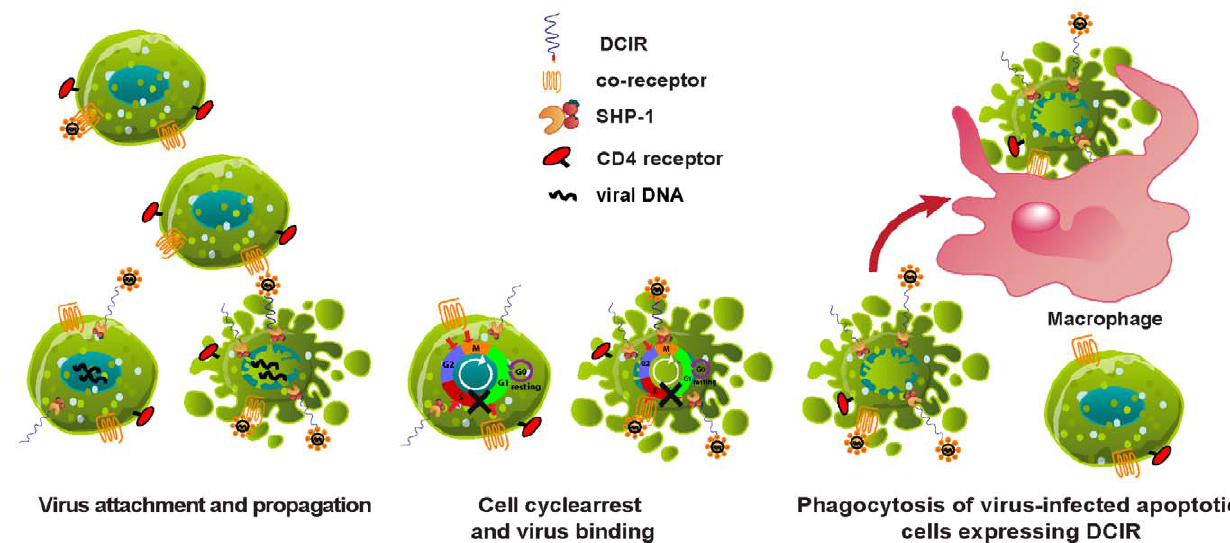
Figure 10. Proposed working models for DCIR involvement in HIV-1 infection. DCIR expression is promoted not only in cells productively infected with HIV-1 but also in bystander cells via both a mitochondrial (intrinsic) caspase-dependent apoptotic pathway and a caspase-independent apoptotic process relying on AIF. The resulting DCIR induction on the surface of CD4 + T cells can affect virus replication by various means. For example, virus binding can be increased through DCIR, a process leading to a more efficient HIV-1 propagation. Moreover, the cell cycle arrest seen in DCIR-expressing cells can also promote virus attachment and the ensuing HIV-1 transmission despite apoptosis induction because of the association between DCIR and SHP-1. It can also be postulated that DCIR expression on the surface of apoptotic CD4 + T cells also infected with HIV-1 might facilitate phagocytosis by macrophages and DCs, thereby favoring infection of such antigen-presenting cells and viral propagation.